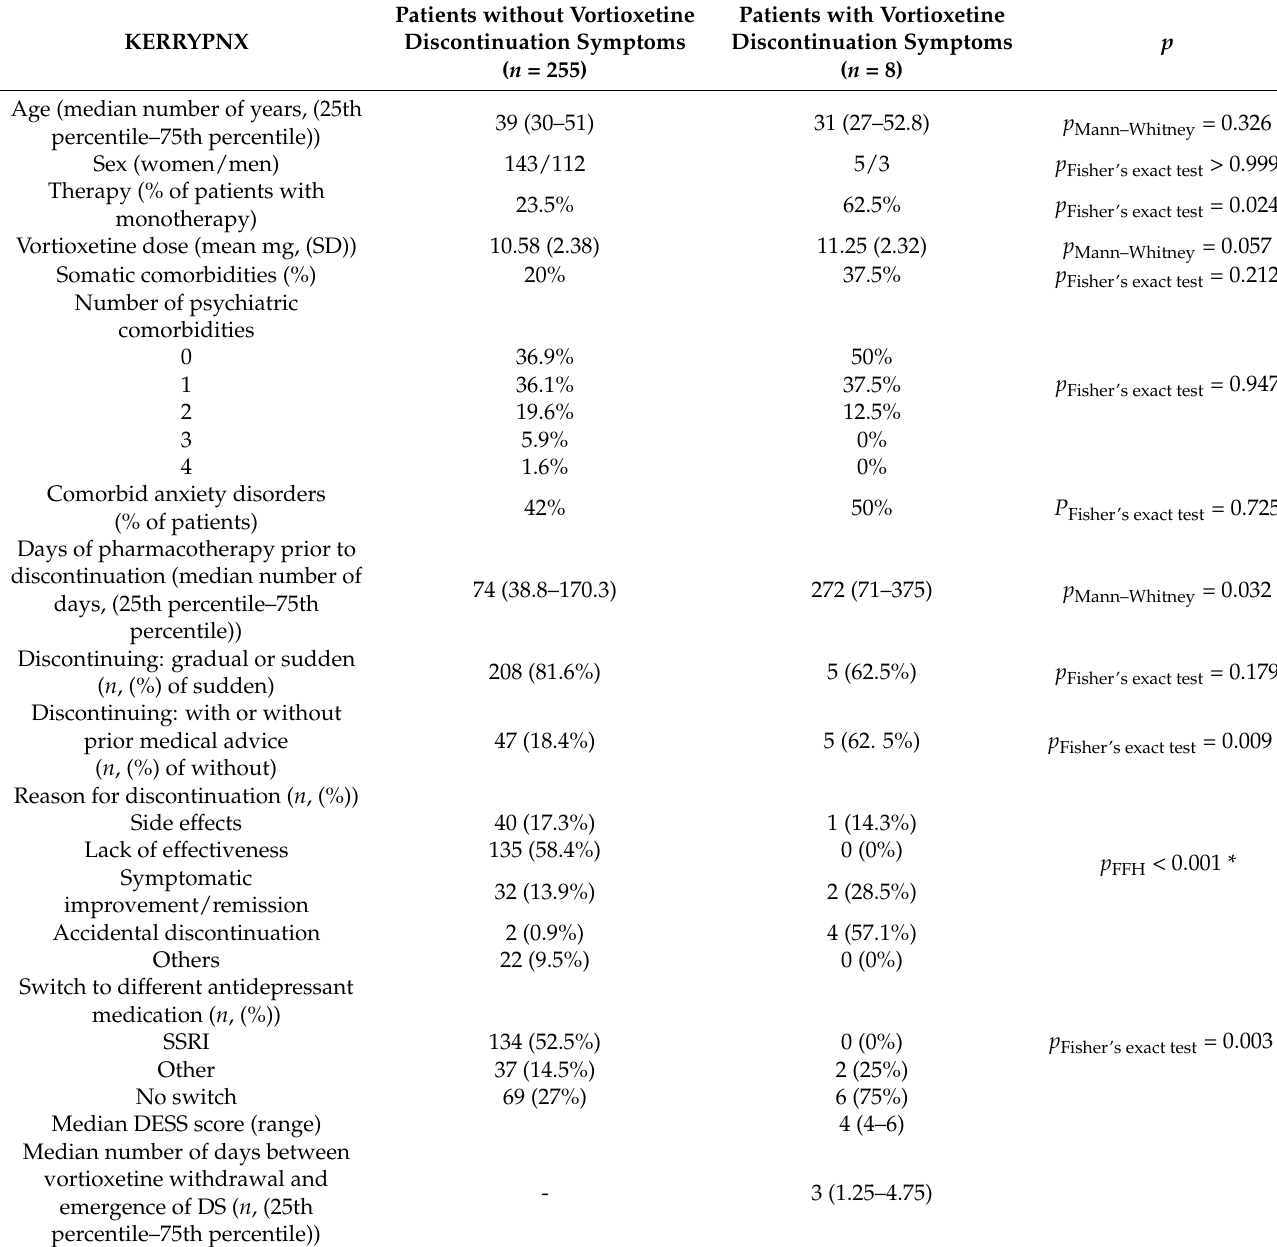
FFH, Fisher–Freeman–Halton’s Test; DESS, Discontinuation-Emergent Signs and Symptoms inventory. DS, discontinuation symptoms. *, comparisons that remained statistically significant after implementing false discovery rate (FDR) p -value correction with Benjamin– Hochberg procedure for multiple